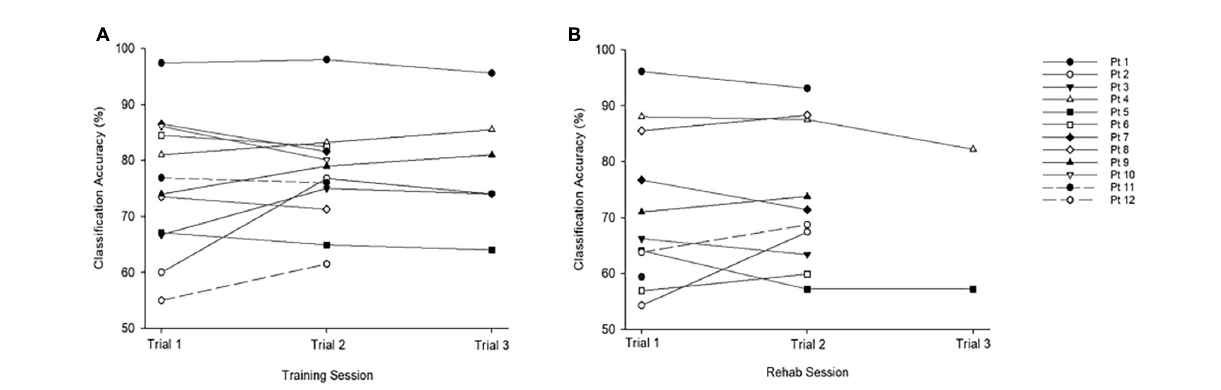
produce a classifier. Using binomial distribution for a 5% significance level, the chance level was calculated to